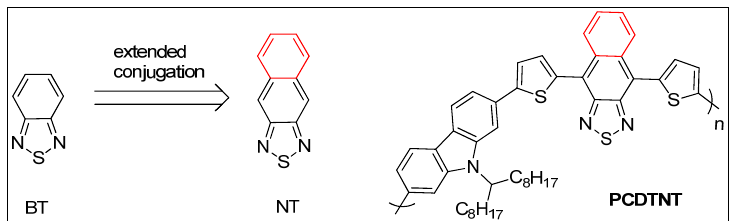
Figure 27. Molecular structure of BT and NT monomers as well as molecular structure of PCDTNT.